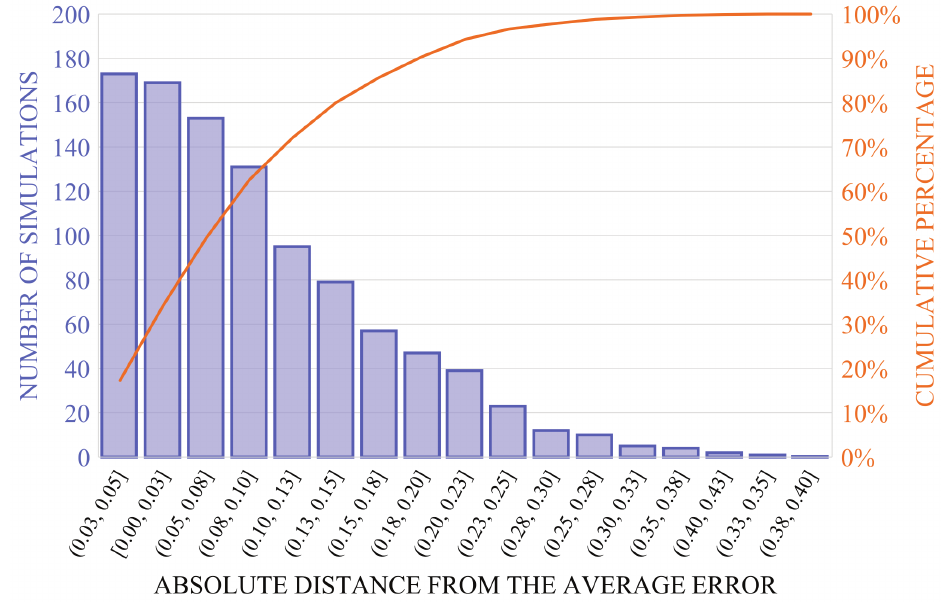
Figure 5. Pareto chart obtained from the absolute distance between the average errors of individual simulations and the average error among all the simulations. Occurrence bars are in descending order.